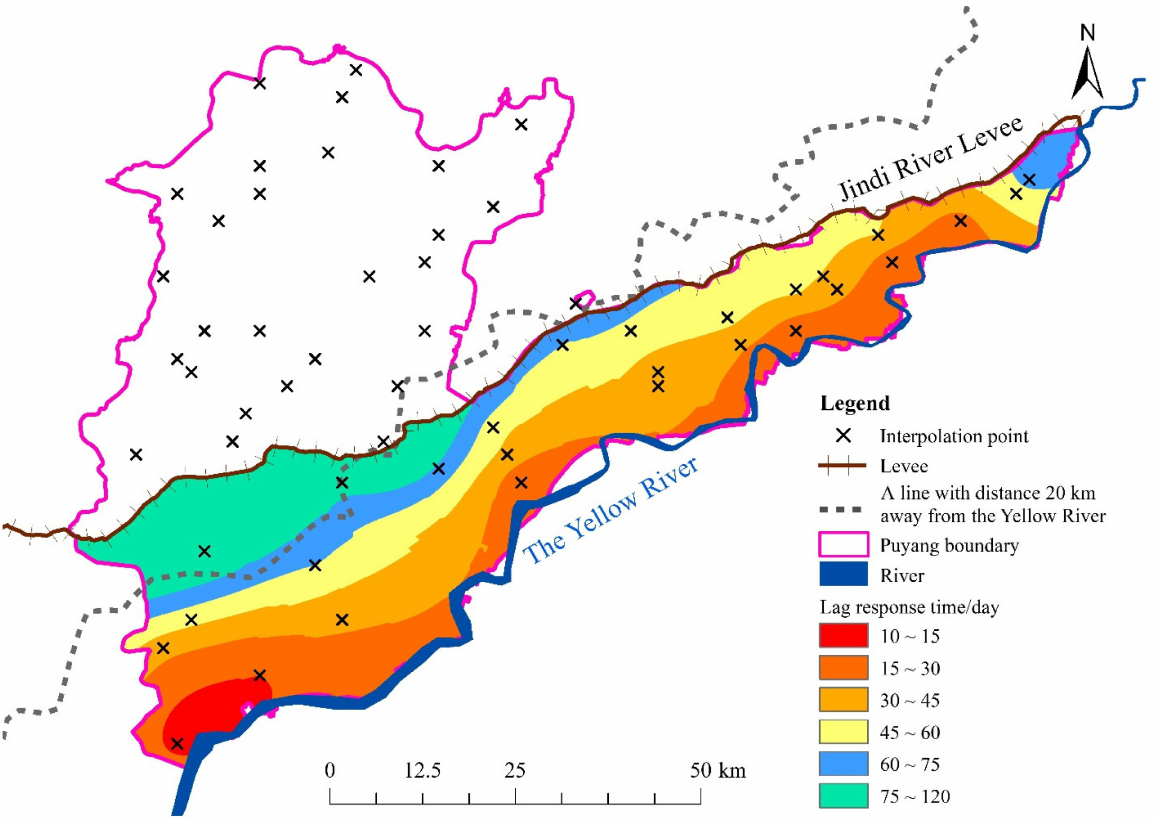
Figure 10. Distribution of the lag response time of groundwater level to water stage of the Yellow River in southern Puyang during the period of